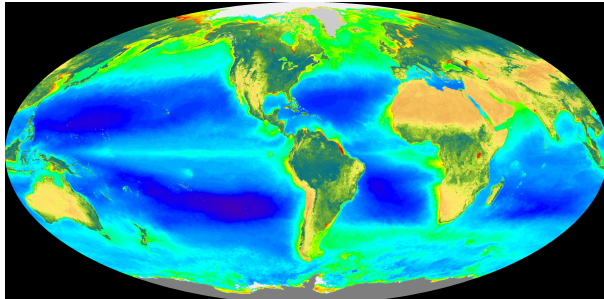
Figure 1. The great biogeoscientist Vladimir Vernadsky gave spe- cial attention to solar radiation driving global photosynthesis and subsequently the global biological, geological, and human re- sponses that follow from this remarkable transfer of “cosmic en- ergy”. The false-color composite image displays ocean chloro- phyll a concentrations from dark blue at ∼ 0 . 05mgm − 3 to green at ∼ 1mgm − 3 to red at >30mgm − 3 and land-normalized differ- ence vegetation index from a minimum as brown to a maximum as dark green to blue. (The image of global photoautotroph abundance is integrated over 20 years from 1997 to 2016 and is provided by the SeaWiFS Project, NASA Goddard Space Flight